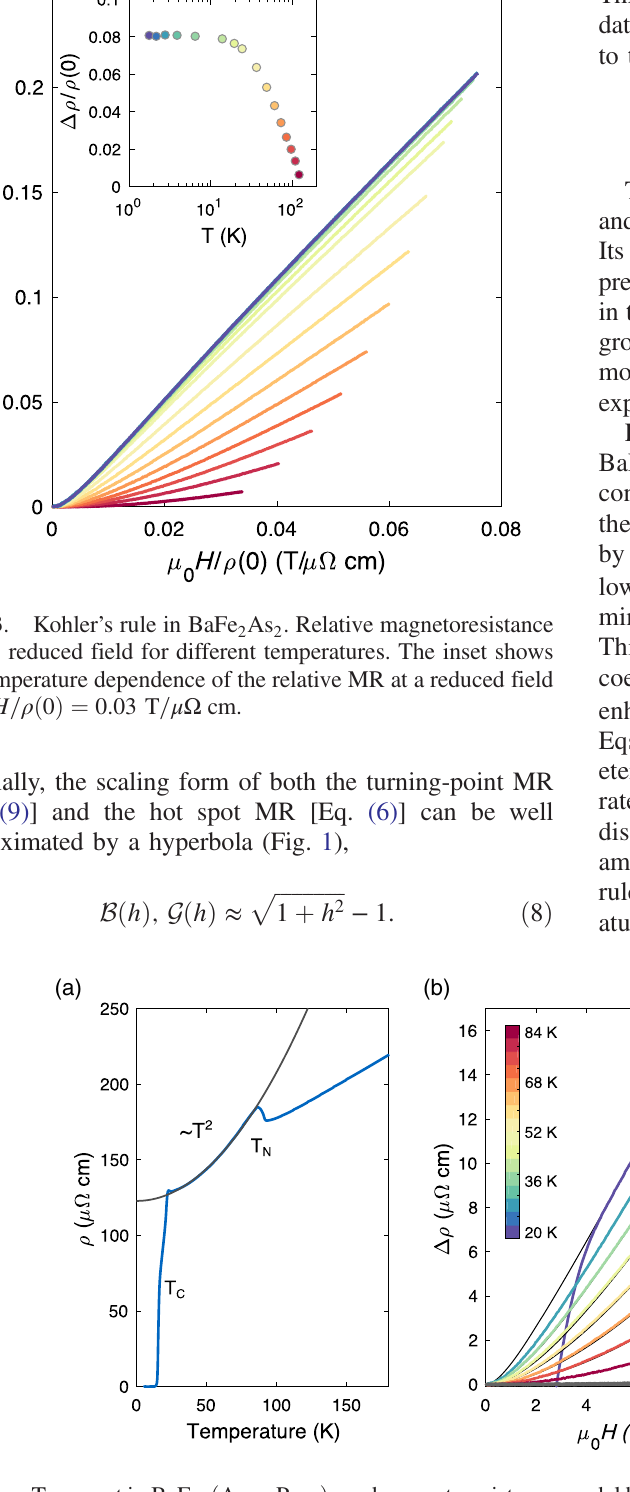
Þ FIG. 4. Transport in BaFe 2 ð As 0 P 0 2 and magnetoresistance model based on turning points. (a) Resistivity shows a transition to an . 81 . 19 AFM ordered state ( T N ≈ 95 K), and superconducting state beginning at T c ¼ 22 K with zero resistance at 15 K. Inside the AFM state, the resistivity varies with T 2 , with a finite T ¼ 0 intercept. The data are fitted well by ρ ð H ¼ 0 Þ ¼ 122 . 8 ½ μ Ω cm (cid:2) þ 0 . 0085 ½ μ Ω cm = K 2 (cid:2) × T 2 (black line). (b) Magnetoresistance for different temperatures with fits to the turning-point MR model [Eq. (3)] indicated by black lines. (c) Fit parameters of the model plotted as a function of temperature, with a best-fit line to the data ¼ 0 . 098 ½ T (cid:2) þ 0 . 0015 ½ T = K 2 (cid:2) × T 2 , and r ¼ 0 . 69 ½ μ Ω cm (cid:2) þ 0 . 0023 ½ μ Ω cm = K 2 (cid:2) × T 2 below 70 K. Here, H tp tp